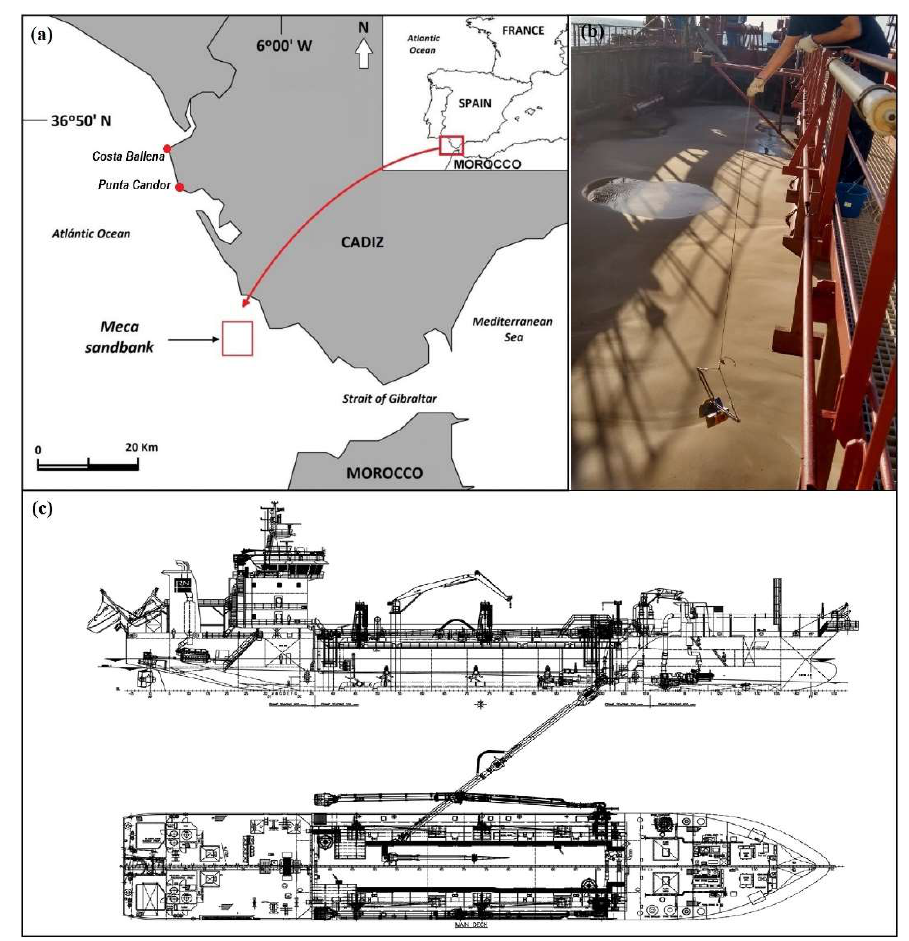
Figure 1. ( a ) Location of Costa Ballena and Punta Candor nourished beaches and the borrow site named “Placer de Meca” (Meca sandbank) (SW Spain); ( b ) sampling method aboard the dredger; ( c ) scheme of Njord dredger (https://rohde-nielsen.com).